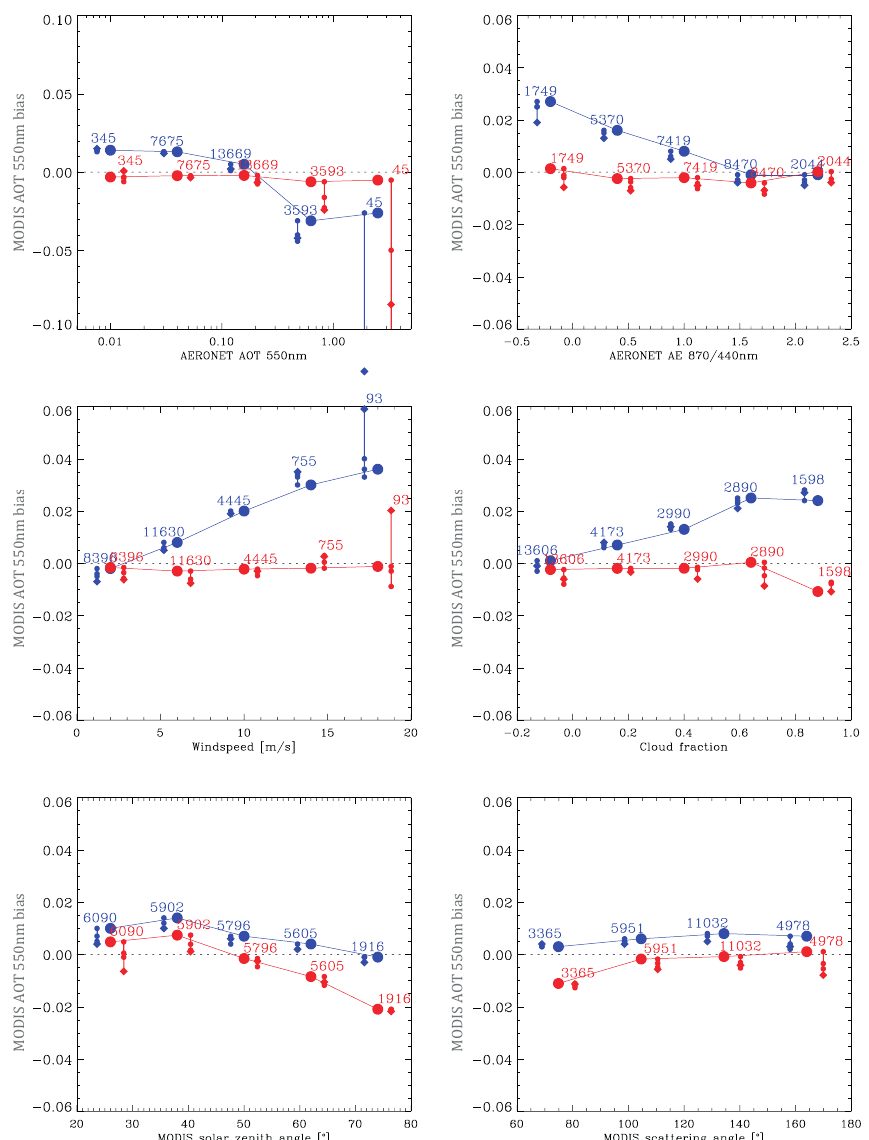
Fig. 10. Biases in Aqua AOT as a function of several variables, for both the original (blue) and corrected (red) observations. The numbers in the plot show sample size per bin. The fatter dots, connected by lines, show the biases for the sub-sample that was used to construct the correction algorithm (closest). The dots along the vertical bars represent the biases for three sub-samples (closest, random or farthest). The diamond represents the bias for the full